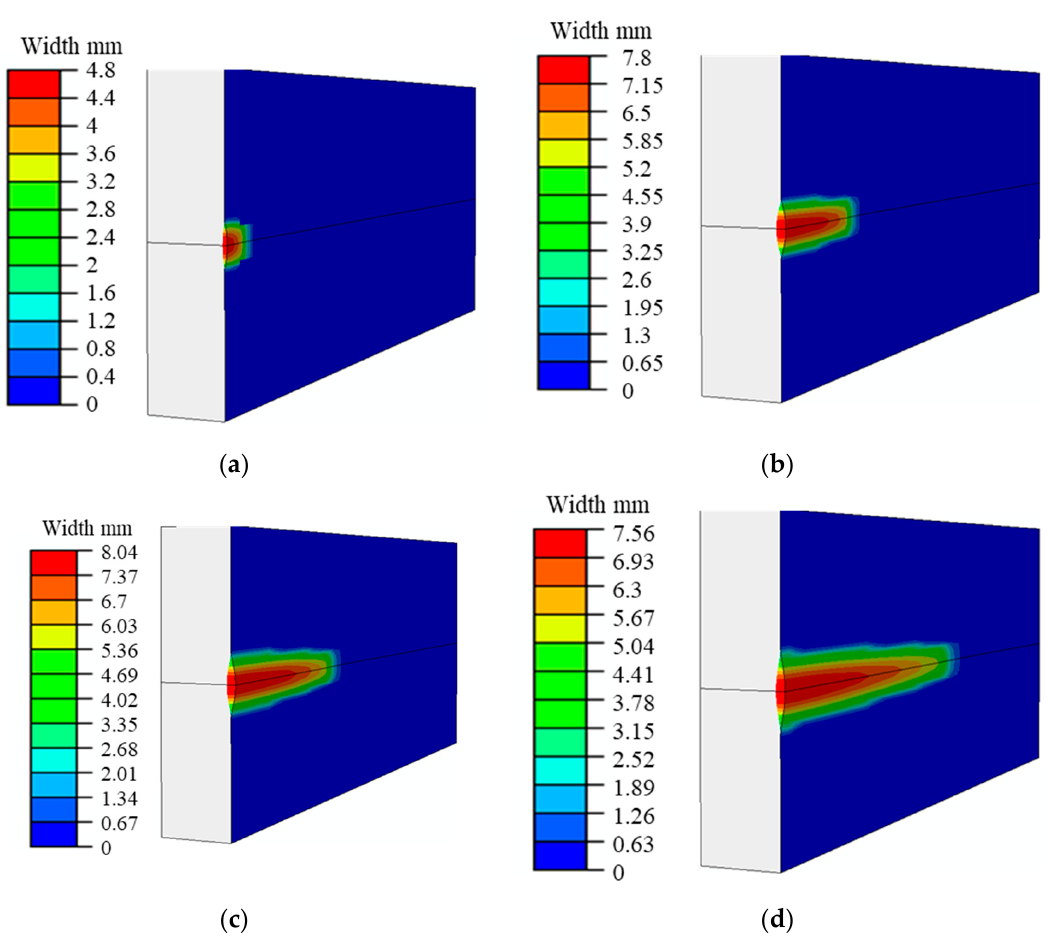
Figure 2. Fracture profile at different times during HF propagation (PFOPEN denotes the HF width, m). ( a ) 1 min; ( b ) 8 min; ( c ) 16 min; ( d ) 24 min.